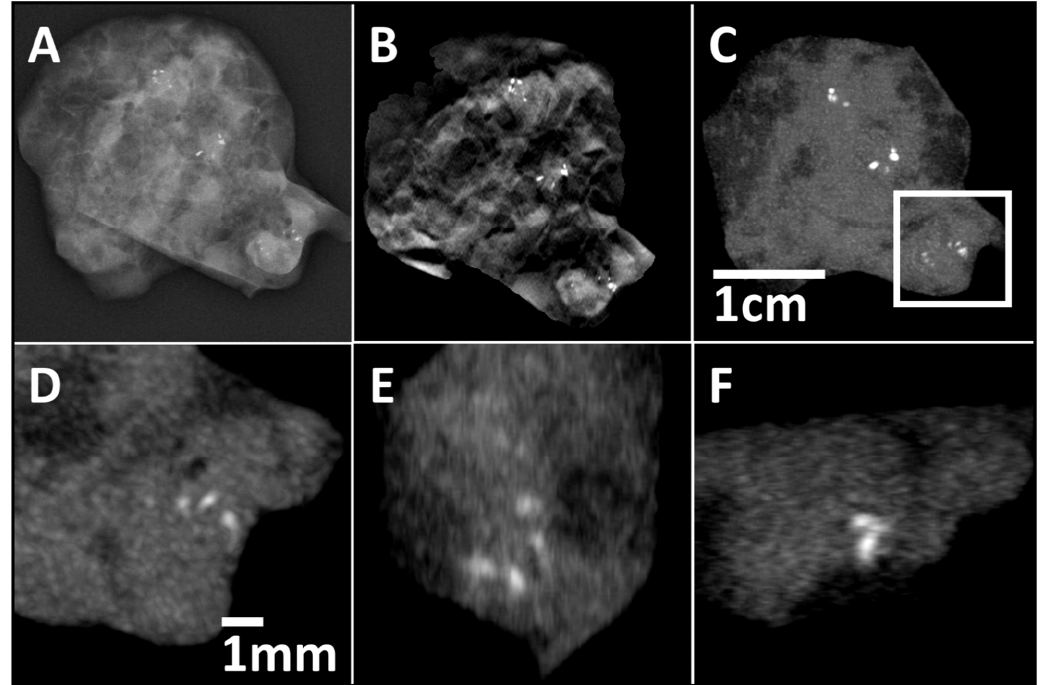
Figure 6. Three different clusters in one specimen can be identified with mammography ( A ), DBT ( B ), and SBCT (Recon2, MIP-reconstruction) with 4 mm slice thickness ( C ). Axial ( D ), sagittal ( E ), and coronar ( F ) MIP-reconstructions with 0.4 mm slice thickness of the cluster in the right lower corner. Details become clearer with thinner slices. A measurement scale for the whole specimen ( A – C ) is inserted in ( C ), and a measurement scale for the cluster in the right lower corner ( D – F ) is inserted in ( D ).